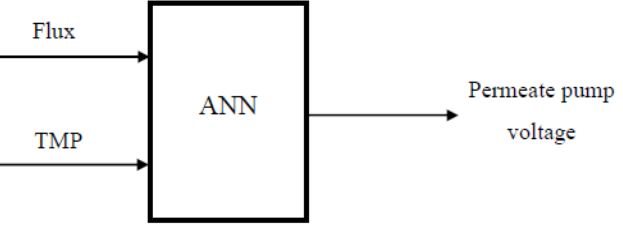
Figure 9. Neural Network Internal Model Control (NNIMC) inverse model training.